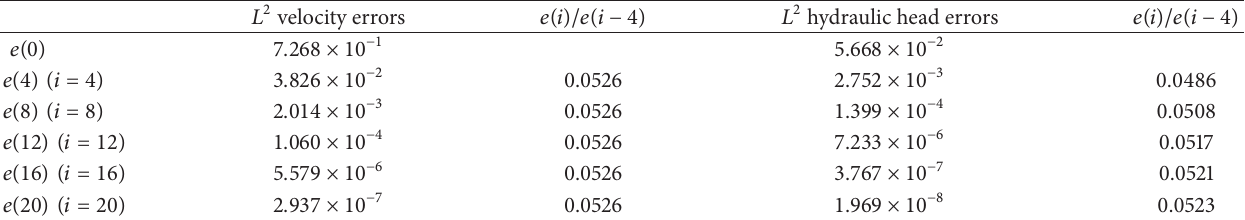
Table 3: 𝐿 2 errors in pressure and 𝜂 𝑓 for the parallel DDM with BJS interface condition.